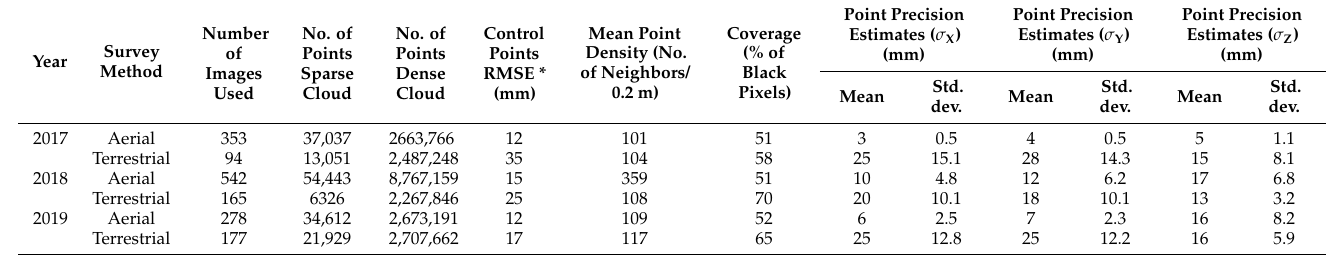
Table 3. Characteristics of the resulting point clouds per year and survey method. The mean point density was evaluated on the dense point cloud at the projection scale of the M3C2 method at 0.2 m. The coverage was assessed by deriving the percentage of black pixels in a PNG format image of each dense point cloud from the top. Please note that the percentage does not portray the actual size of the holes, as the surroundings of the sinkhole are also in black. The PNGs can be found in